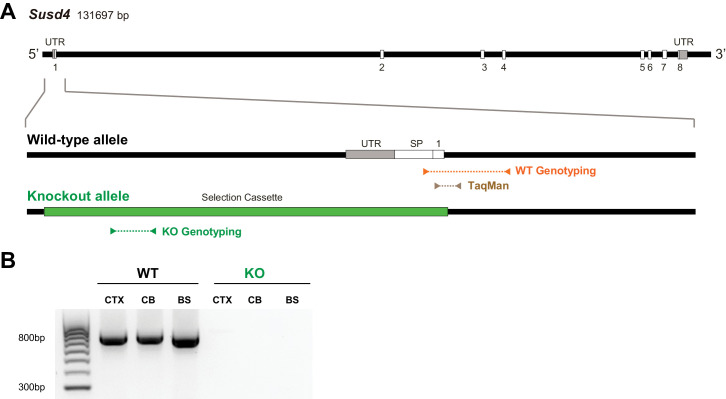
Characterization of Susd4 knockout (KO) mice.(A) Structure of the Susd4 gene and strategy for the generation of the KO mouse. The gene coding for the Susd4 mRNA contains eight exons. The wild-type (WT) allele is presented indicating the localization of the primers used for genotyping and of the probes used for TaqMan RT-qPCR. In the KO allele, the 5'UTR and first exon are entirely deleted and replaced by the selection cassette. (B) Susd4 expression was assessed by RT-PCR using primers encompassing exons 6-8 in extracts from cortex (CTX), cerebellum (CB), and brainstem (BS) in Susd4 WT and Susd4 KO mice.